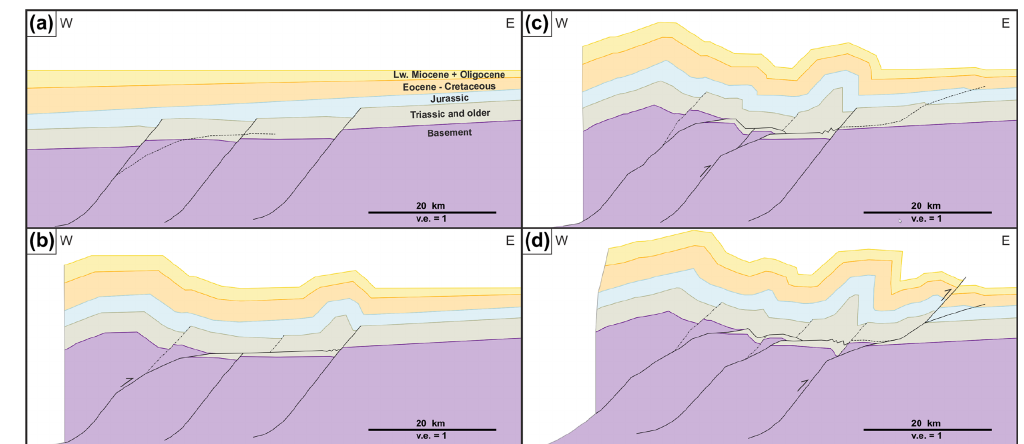
Figure 17. Simplified kinematic evolution of the northern sector, shown for Eocene to basement rocks. (a) Pre-contractional situation with Jurassic normal faults. Stippled line indicates future shortcut fault. Panels (b) and (c) show increments of inversion with shortcut faulting and detachment folding related to buttressing. (d) Final geometry of the kinematic forward